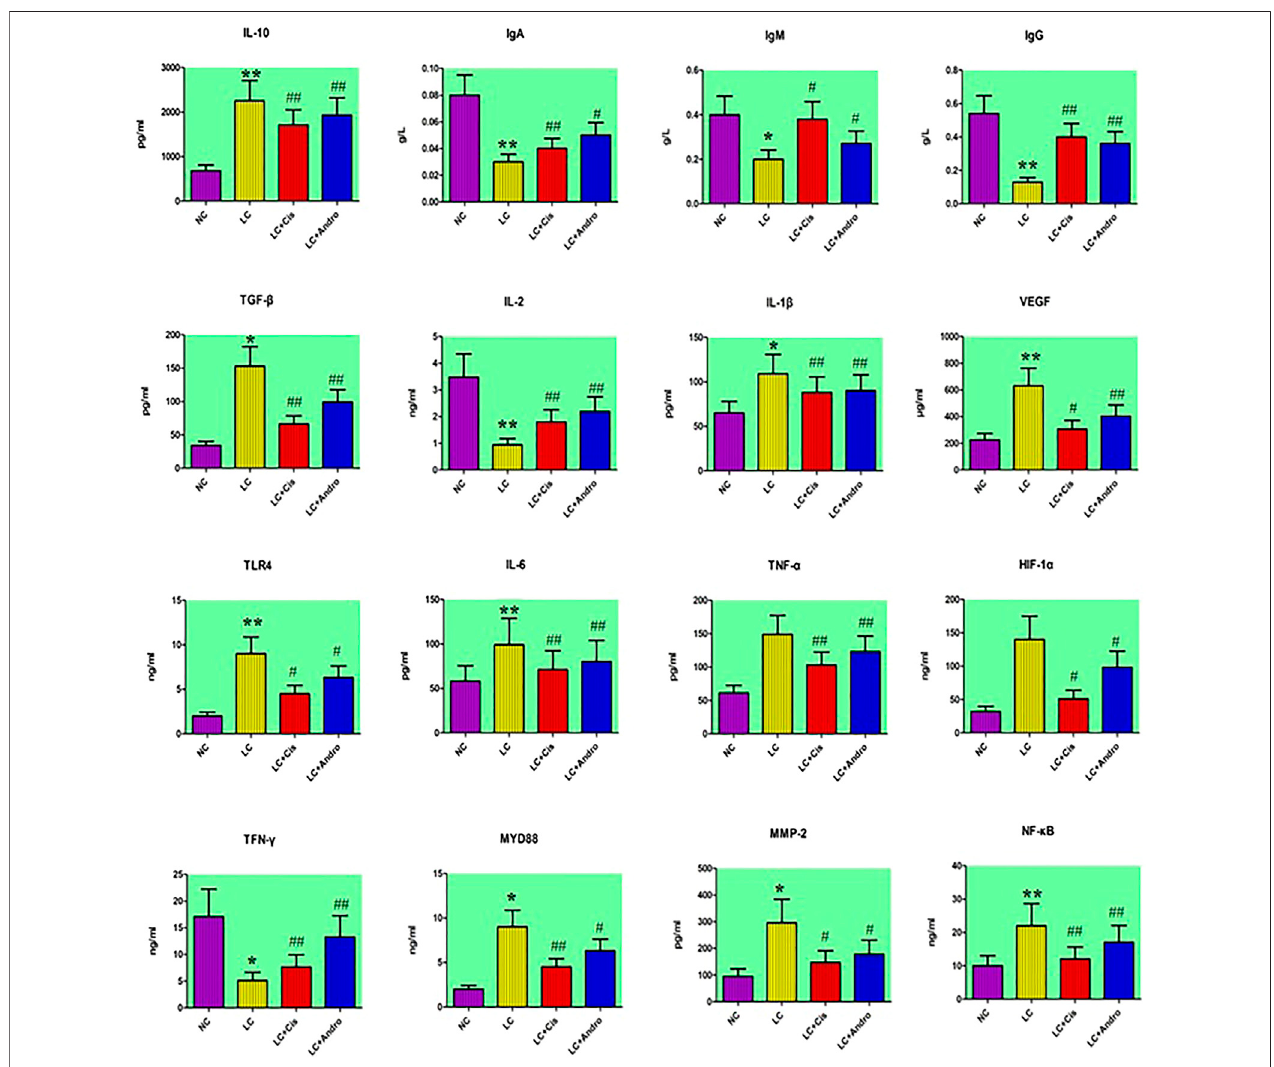
FIGURE 1 | The changes of chemical indexes content in different groups after Andro administration. “ * ” LC group vs NC group, p < 0.05; “ ** ” LC group vs NC group, p < 0.01; “ # ” LC + Cis or LC + Andro group vs LC group, p < 0.05; “ ## ” LC + Cis or LC + Andro group vs LC group, p < 0.01.